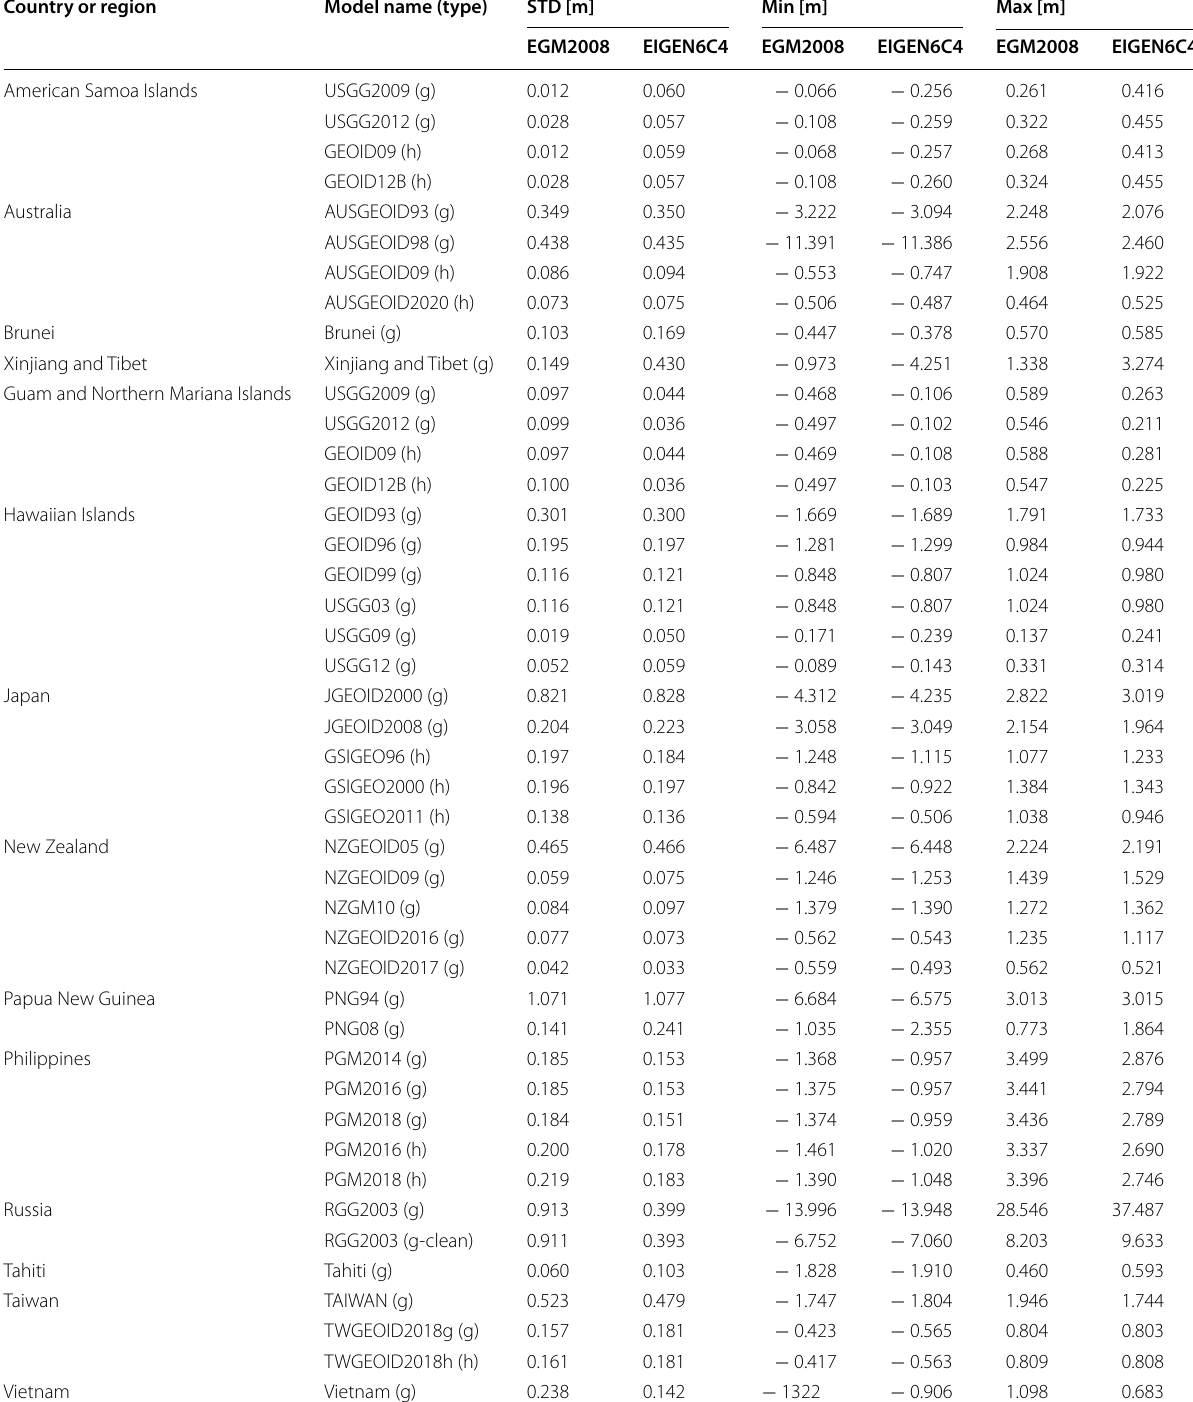
Table 8 Statistics on the residuals of the comparison between the Asia–Pacific geoid models available in the ISG repository with respect to EGM2008 and EIGEN6C4 global